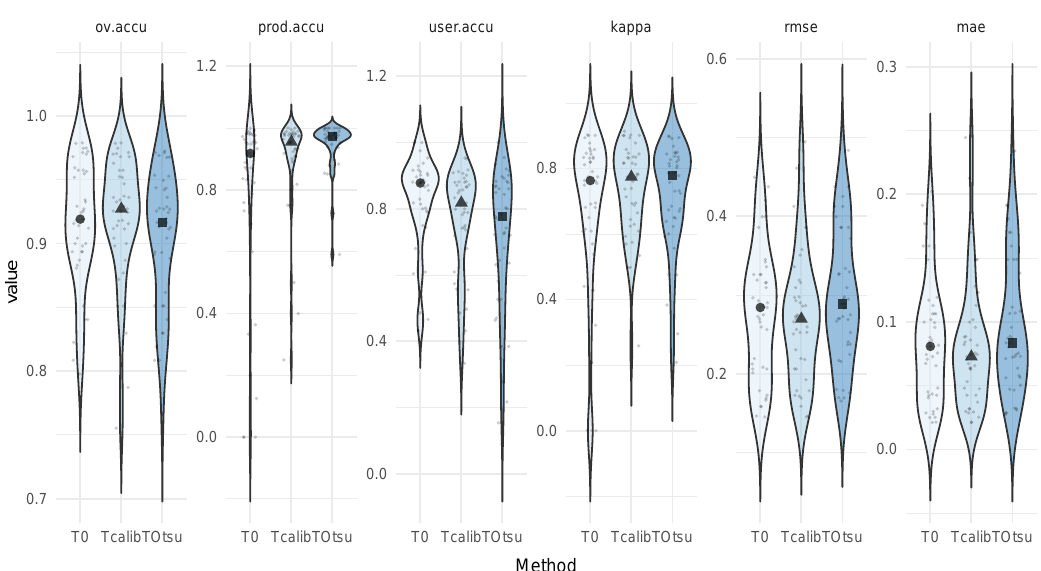
Figure 6. Violin box plots of six accuracy metrics for the three methods on multi-sensor MNDWI imagery (Landsat 7, Landsat 8, Sentinel-2 and MODIS) over the 2017 and 2019